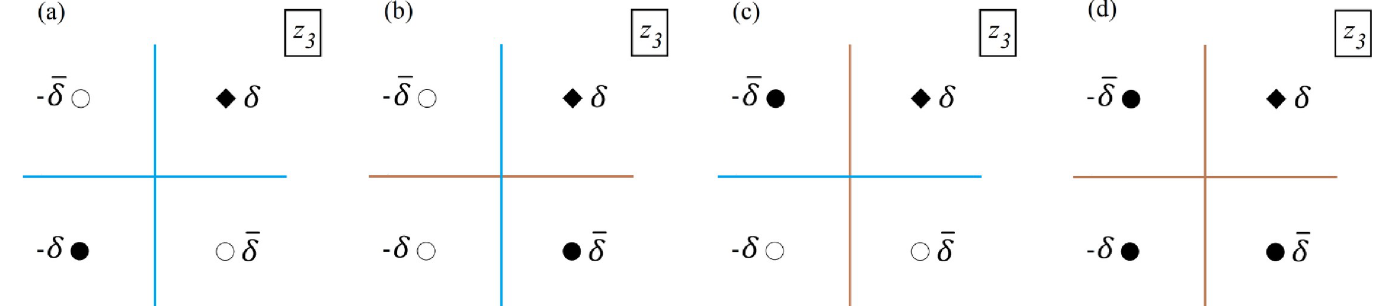
Fig 3. The conceptual model in the z 3 − plane . Solid diamonds are locations of the real wells. Solid circles are the image wells of the same type as the real well (i.e., injection/extraction) and the hollow circles denote image wells of the opposite type to the real well. δ shows the spatial location of the extraction or injection well in the z 3 − plane and d is complex conjugate of δ